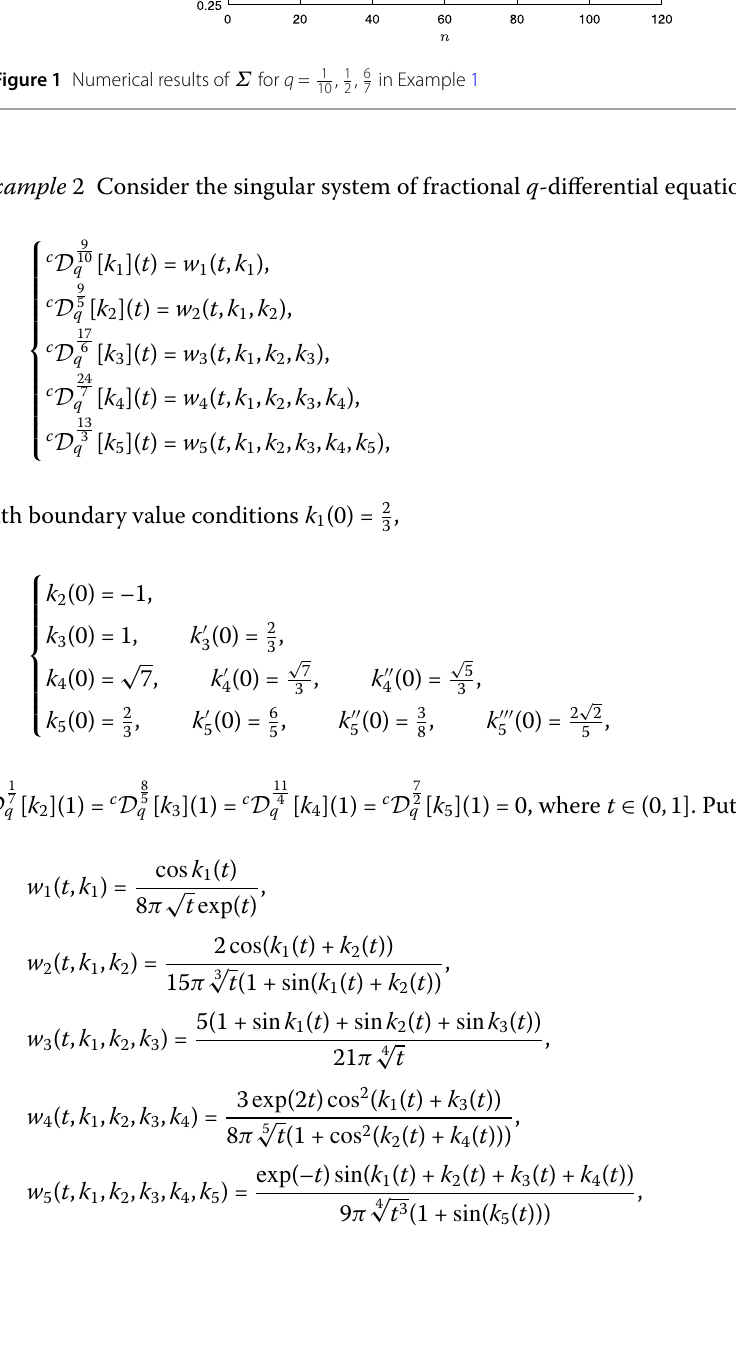
Figure 1 Numerical results of Σ for q = 1